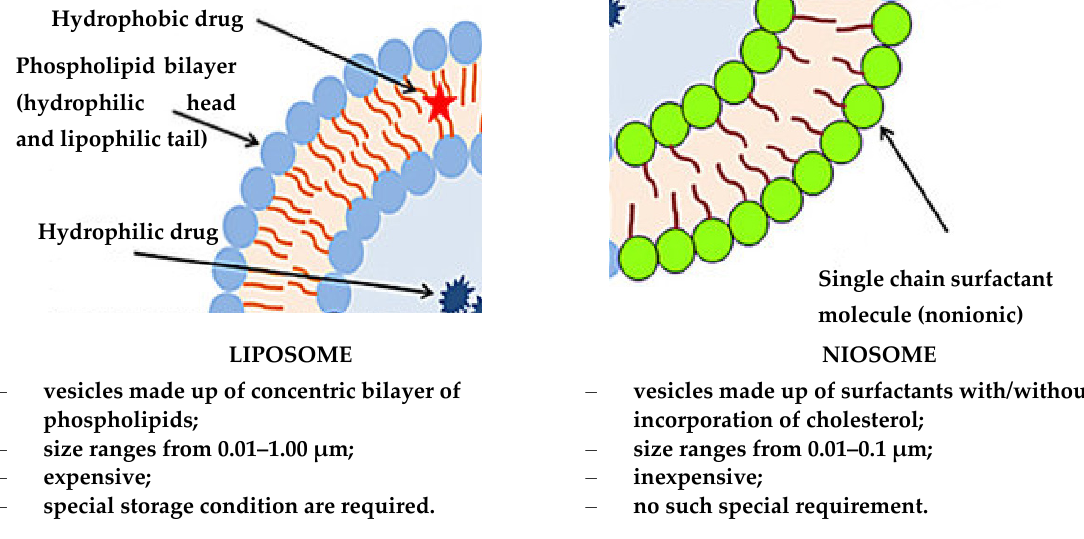
Figure 2. Schematic of the structure of the liposome and niosome (modified from [54]; original paper under the terms of the Creative Commons CC BY-NC 3.0).